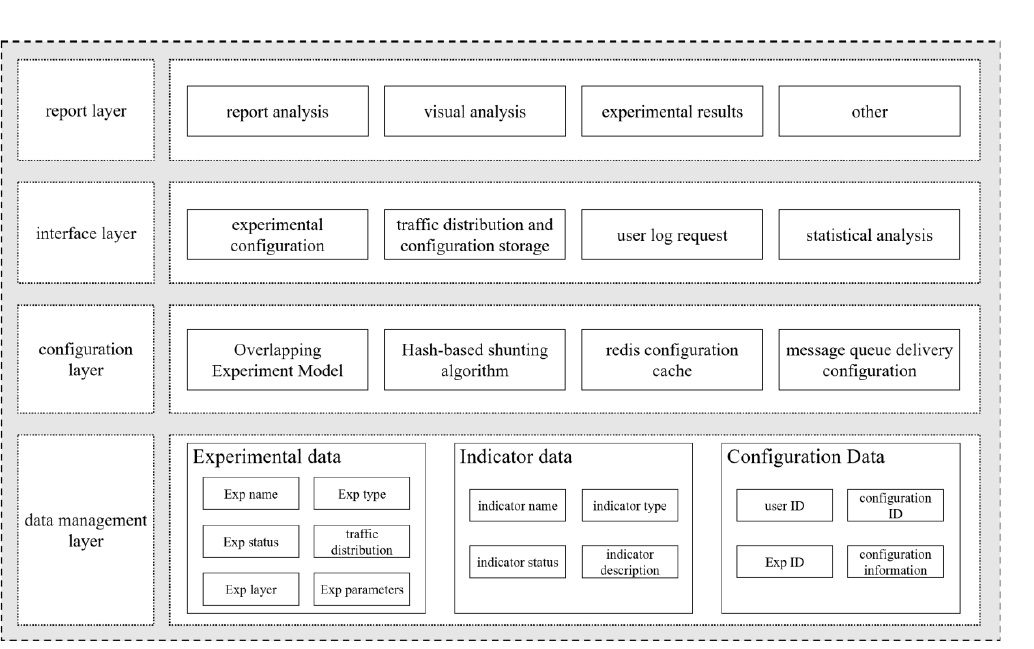
Figure 5. Layered multiplexing of traffic.